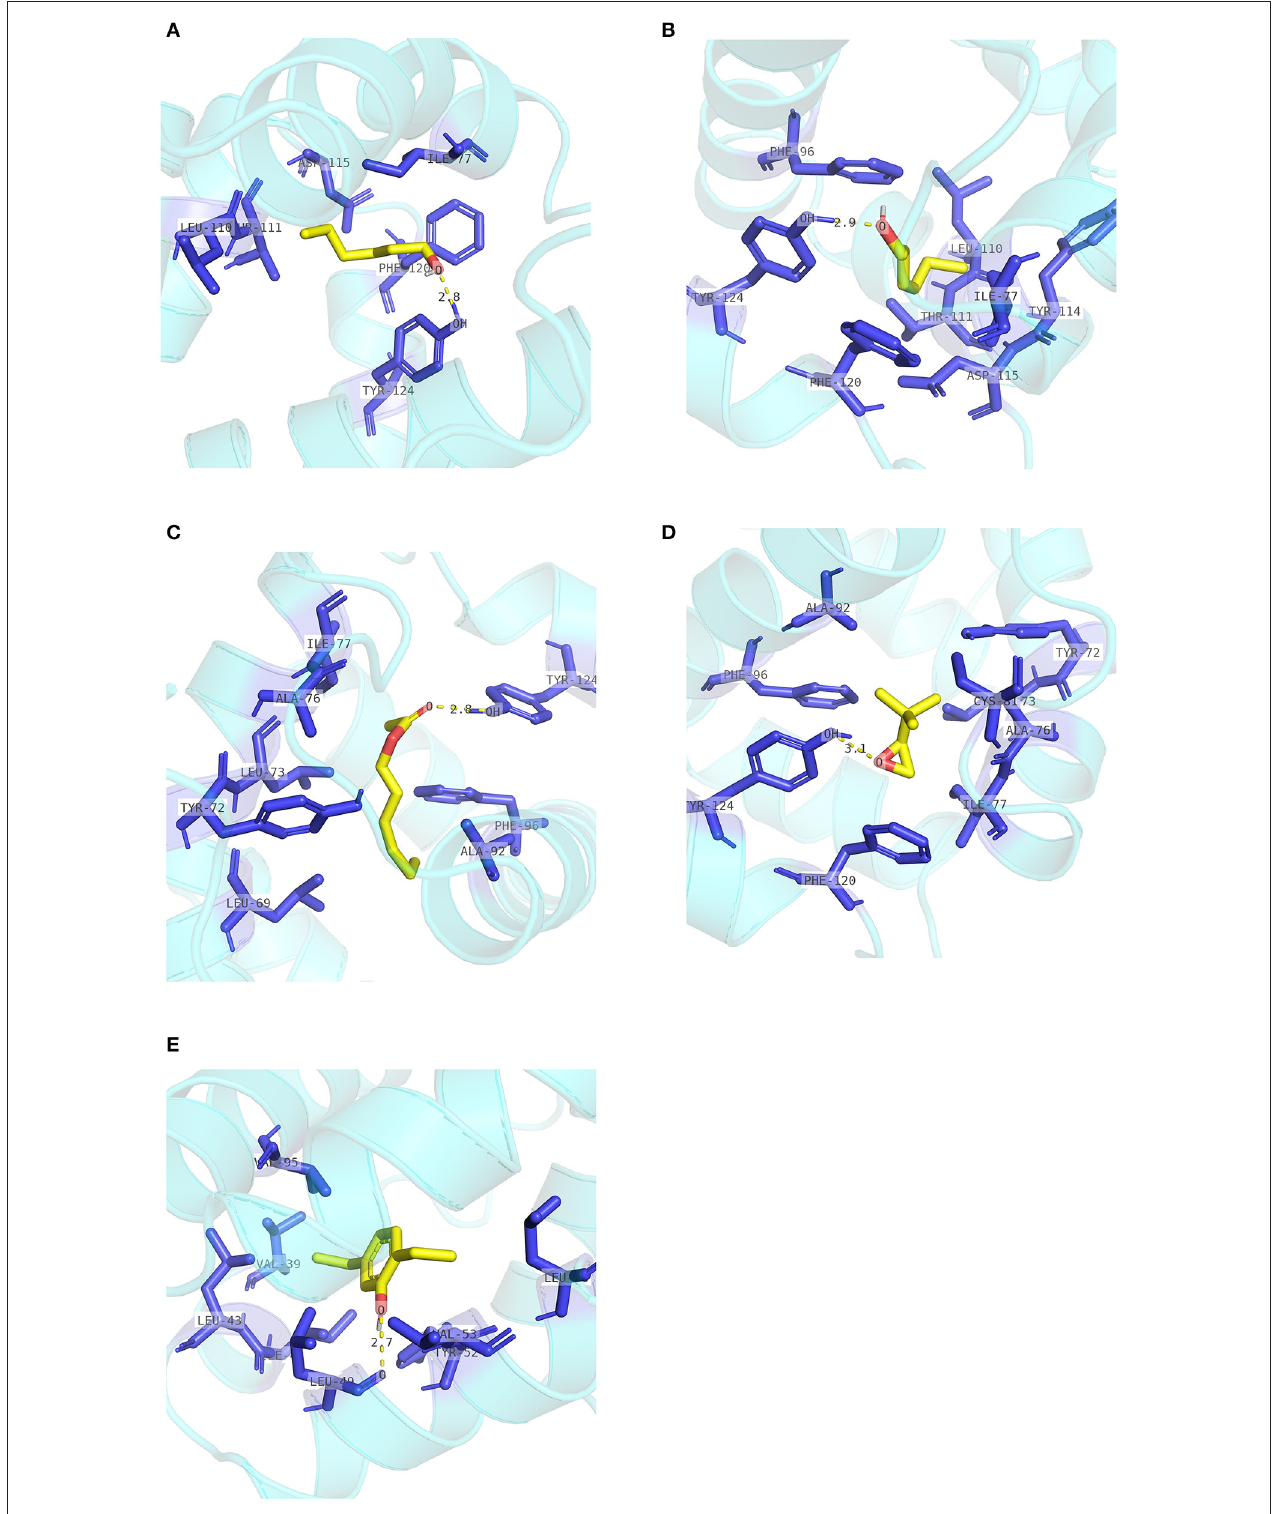
FIGURE 9 | Internal contacts of ligands with EscrCSP8a residues. Blue sticks represent non-ligand residues involved in hydrophobic contacts; yellow dotted line represent hydrogen bond and its length. (A) Internal contacts of 1-hexanol and with EscrCSP8a residues. (B) Internal contacts of cis-3-hexen-1-ol with EscrCSP8a residues. (C) Internal contacts of hexenyl acetate with EscrCSP8a residues. (D) Internal contacts of 2-tert-butyloxirane with EscrCSP8a residues. (E) Internal contacts of 2,5-diethylphenol with EscrCSP8a residues.